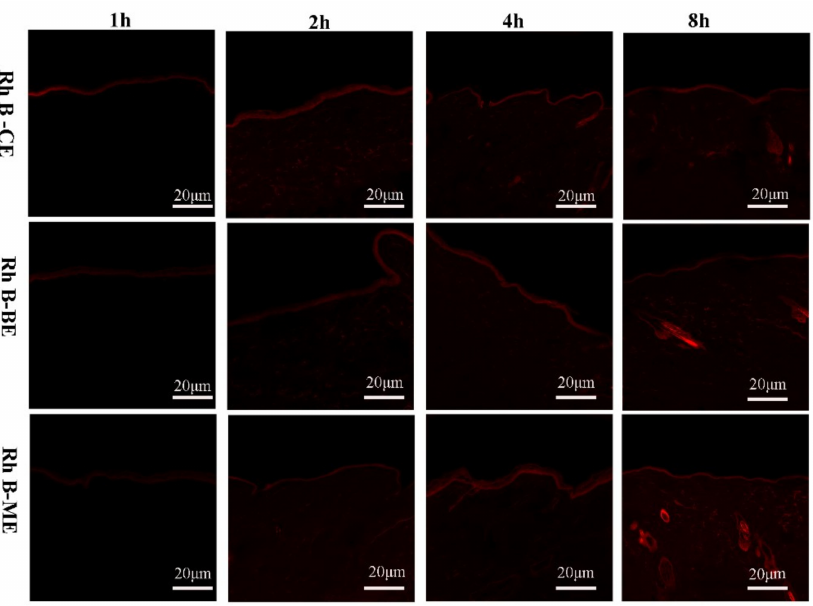
Figure 4. Confocal Laser Scanning Microscopy (CLSM) images of vertical section of rat skin incubated with Rh B labeled formulations at 1, 2, 4, and 8 h